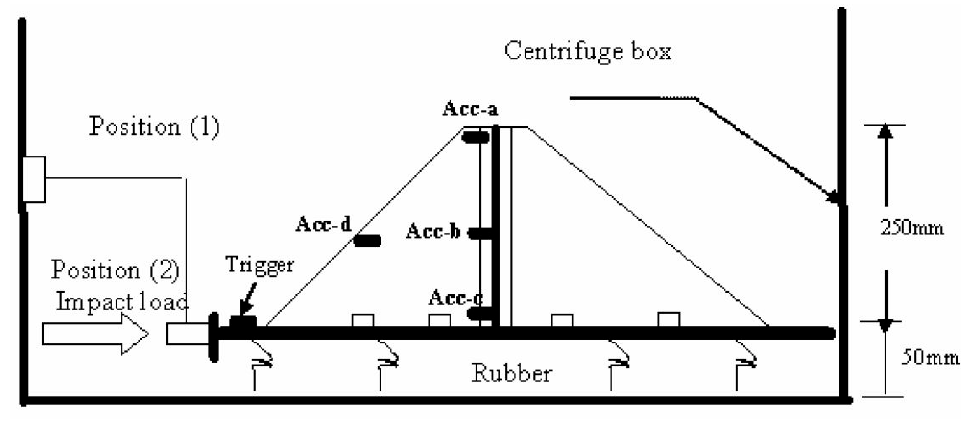
Figure 12. Centrifuge model [31].